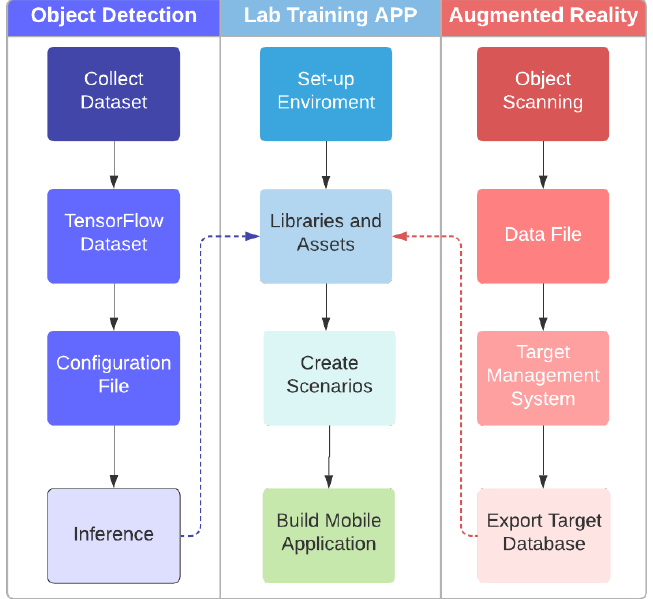
Figure 2. Design framework of AR-based smartphone app for lab equipment